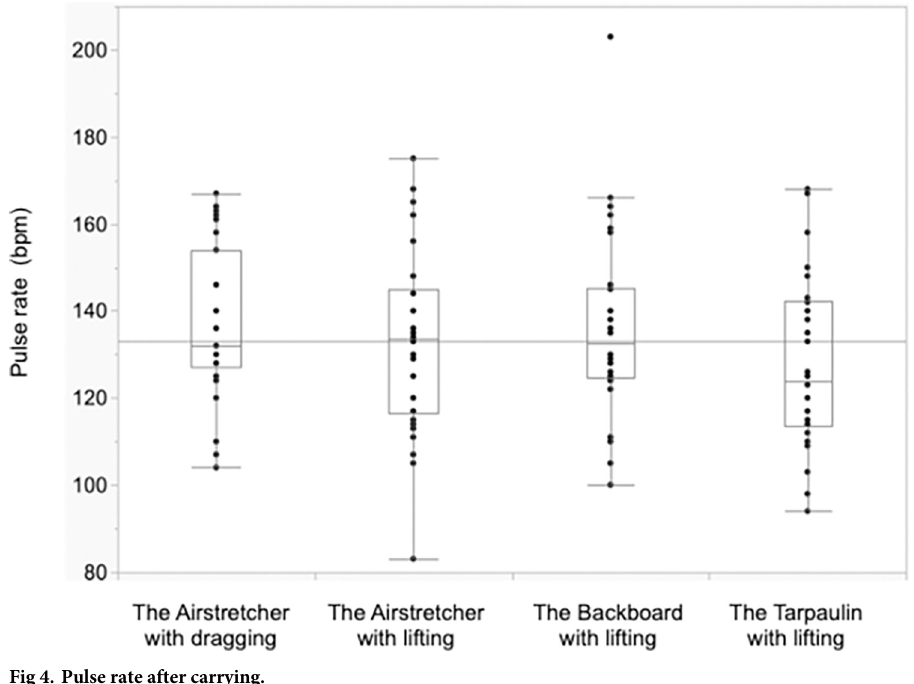
Fig 4. Pulse rate after